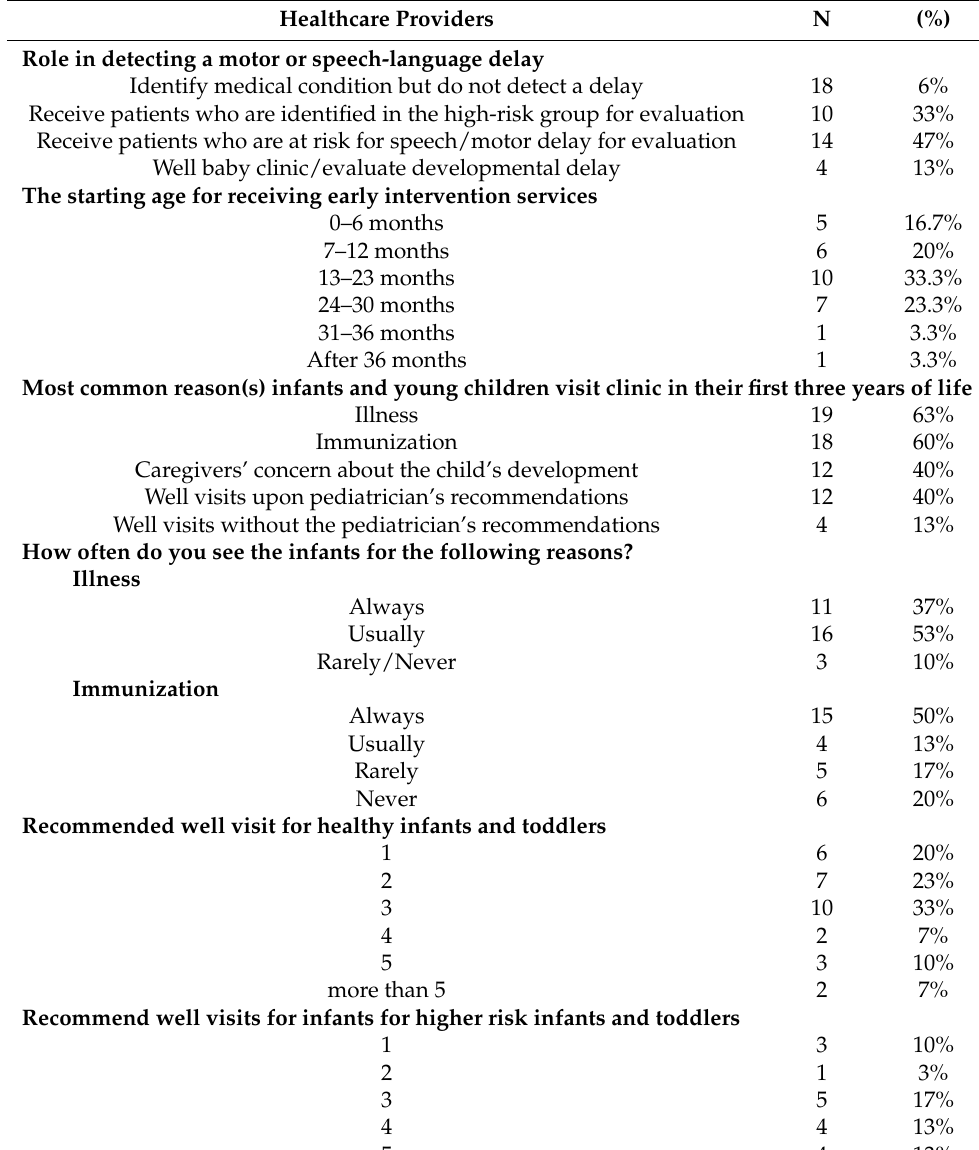
Table 2. Early Detection Practices from Health Care Providers’